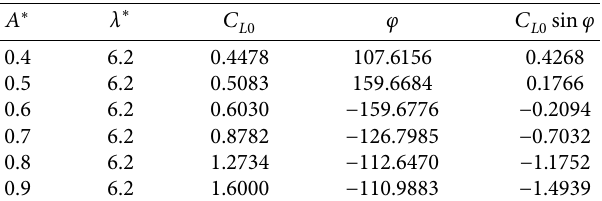
Table 4: Forced oscillating response at different amplitude ratio A ∗ at λ ∗ � 6 .